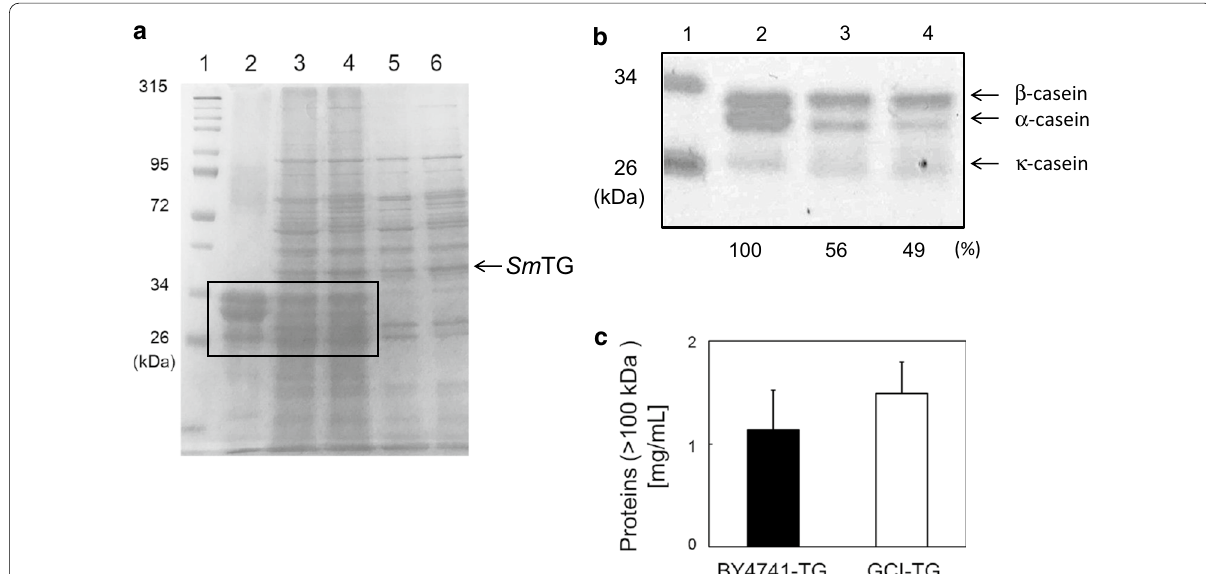
Fig. 4 Polymerization of caseinate by Sm TG extracted from BY4741‑TG and GCI‑TG strains. Each sample volume loaded was 20 µL ( a ) and 5 µL ( b ). a Lane 1, protein molecular size marker; lane 2, caseinate control; lane 3, polymerized caseins by 12 4, polymerized caseins by 12 Sm TG extracted from the GCI‑TG strain; lane 5, BY4741‑TG extract; lane 6, GCI‑TG extract. b Expanded region of the × SDS‑PAGE in ( a boxed region). Ratios of cross‑linked α‑casein were calculated from the intensity of each α‑casein band and represented as relative values (%). c The concentration of proteins whose molecular weights were more than 100 kDa, were detected after polymerization of caseinate by 12 Sm TG extracted from the BY4741‑TG and GCI‑TG ×